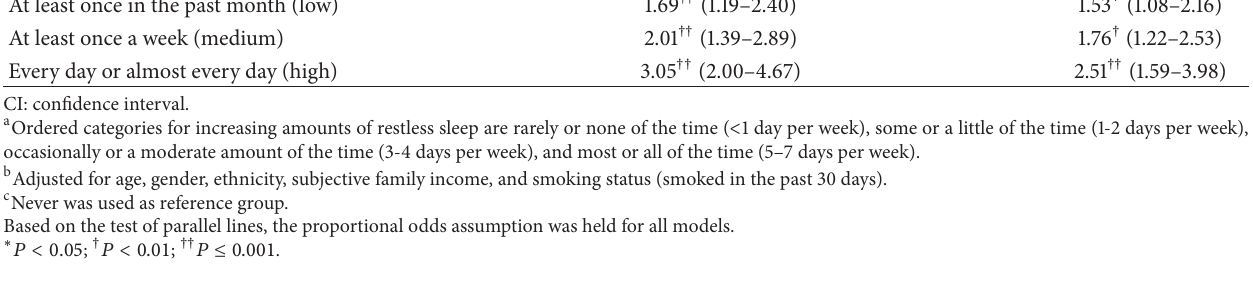
Table 3: Associations between frequency of SHS exposure and sleep duration in a sample of adolescents ( 𝑁 = 1 ,466).